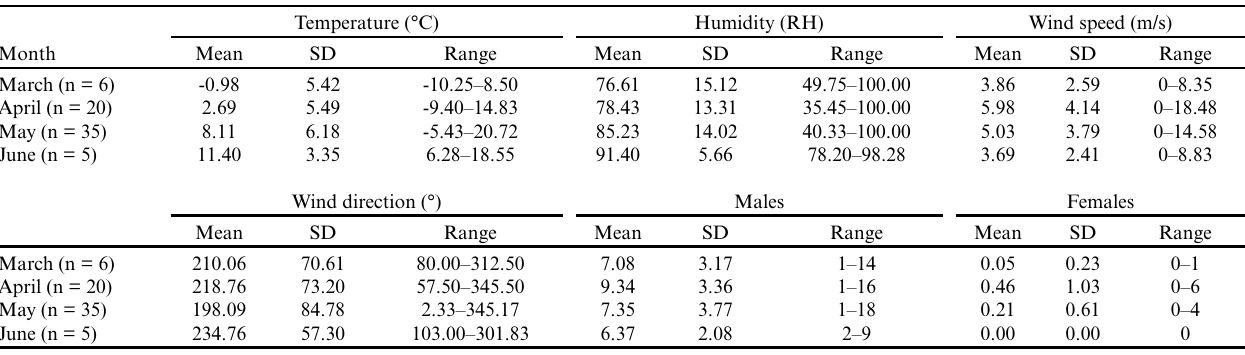
Table 1 . Summary of monthly at-lek weather conditions and lek attendance for Greater Prairie-Chicken ( Tympanuchus cupido ) during male chorus recordings of leks near Ainsworth, Brown County, Nebraska, USA, 2013–2014. Number of recording days for each month is indicated next to